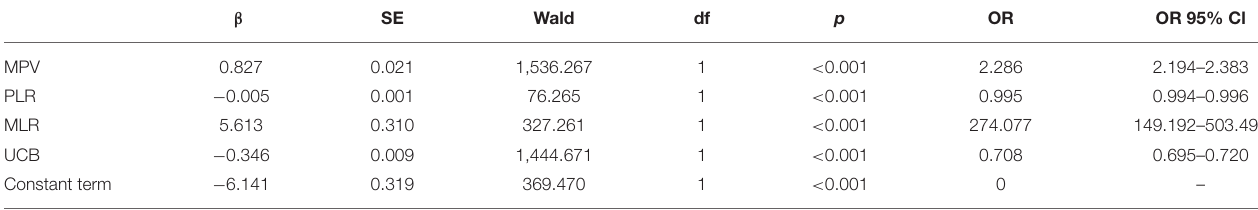
TABLE 3 | The combined equation of logistic regression model with risk factors of schizophrenia compared with healthy control groups. β SE